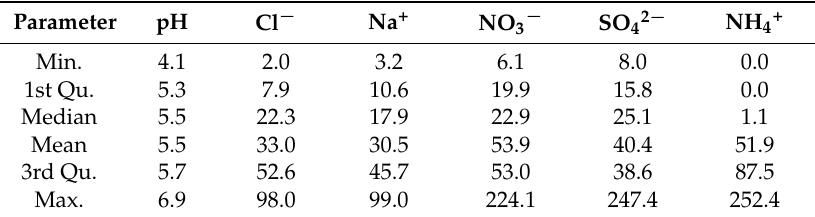
Table 1. Minimum (Min), first quartile (1st Qu), median, mean, third quartile (3rd Qu) and maximum (Max) values for samples considered in this work (24 observations). Concentrations are reported in µ M as in Deguillaume et al.